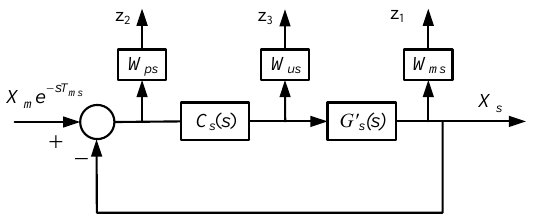
Figure 5. The structure of local slave controller